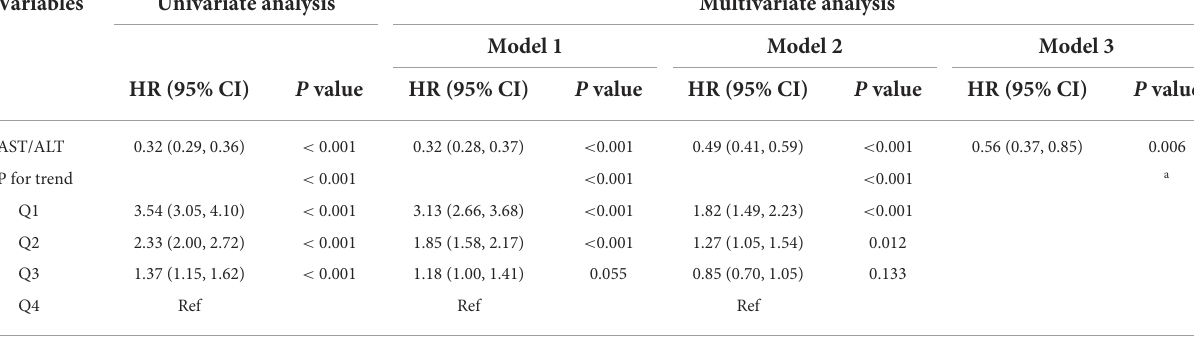
TABLE 2 Univariate and multivariate Cox proportional hazards regression analyses for the association between AST/ALT (DeRitis) ratio and incident diabetes in different